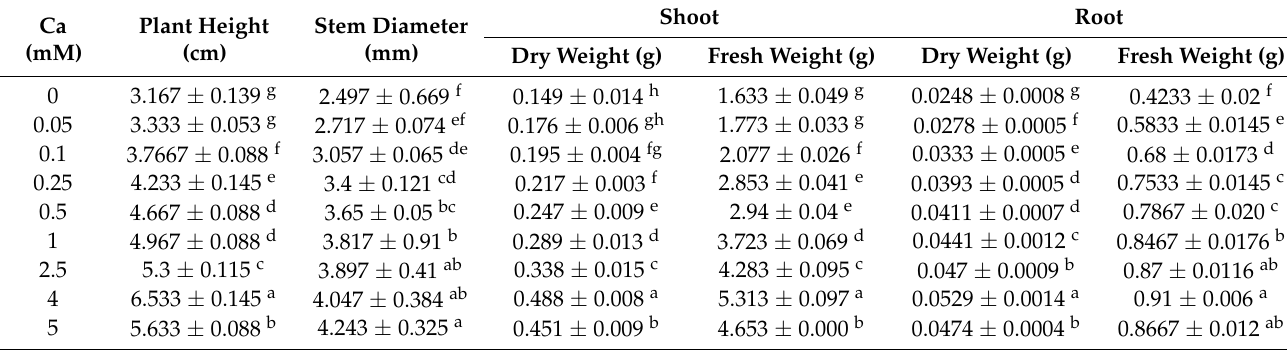
Table 2. Calcium concentration